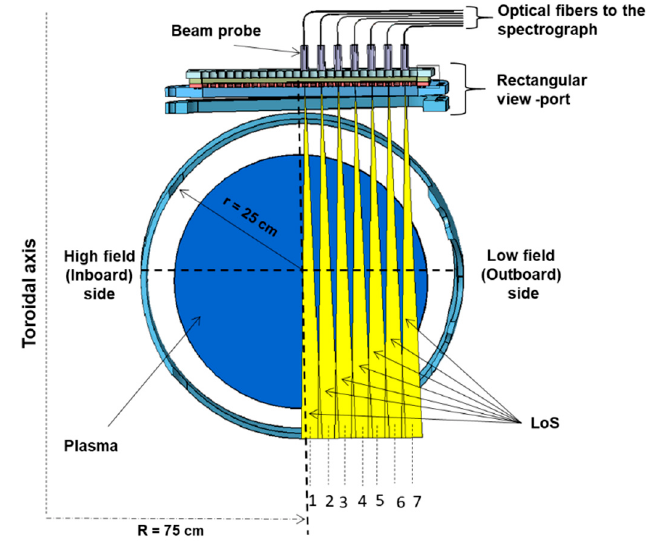
Figure 1. Schematic of the viewing geometry that was used for the multi-track spectrometer. The lines of sight are represented by Fibers 1 to 7 passing through the plasma radial locations of 1.65, 4.95, 8.25, 11.60, 14.90, 18.20, and 21.44 cm.